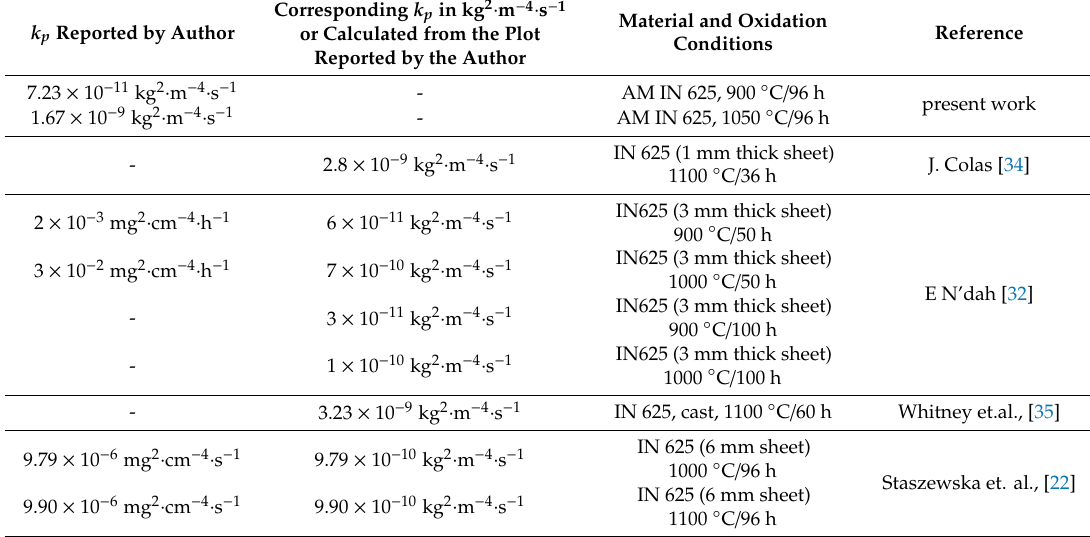
Table 4. k p values registered for di ff erent oxidized Ni-based